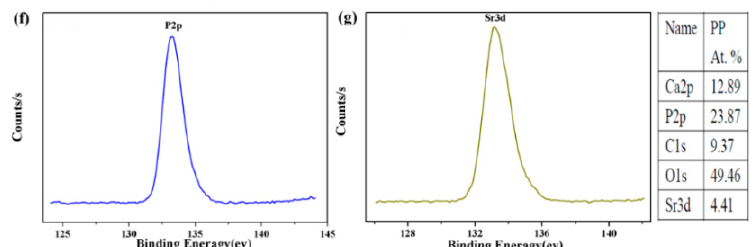
Figure 1. ( a ) SEM and ( b , c ) XRD pattern of SrHA sample and the control HA sample. ( d ) X-ray photoelectron spectroscopy (XPS) survey scan and high-resolution XPS spectra of the ( e ) Ca2p peak, ( f ) P2p peak, and ( g ) Sr3d peak peaks of the SrHA.